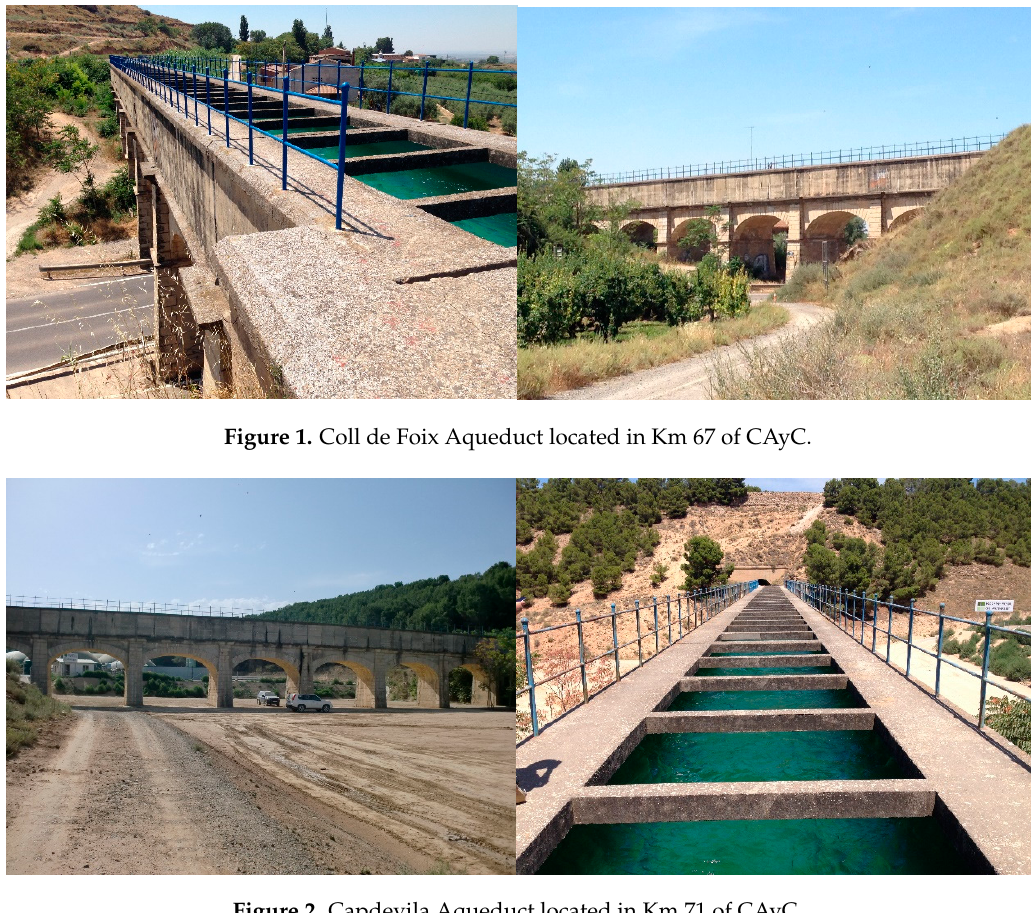
Figure 2. Capdevila Aqueduct located in Km 71 of CAyC.